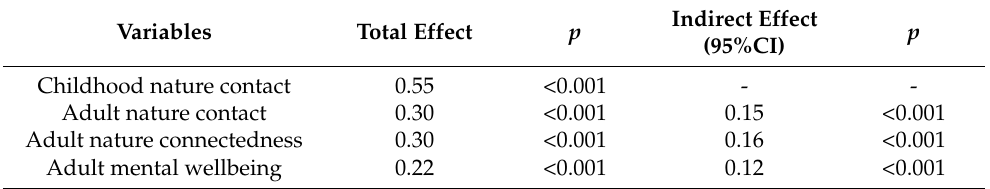
Table 3. Standardized total and indirect effects of childhood residential green space on core variables.